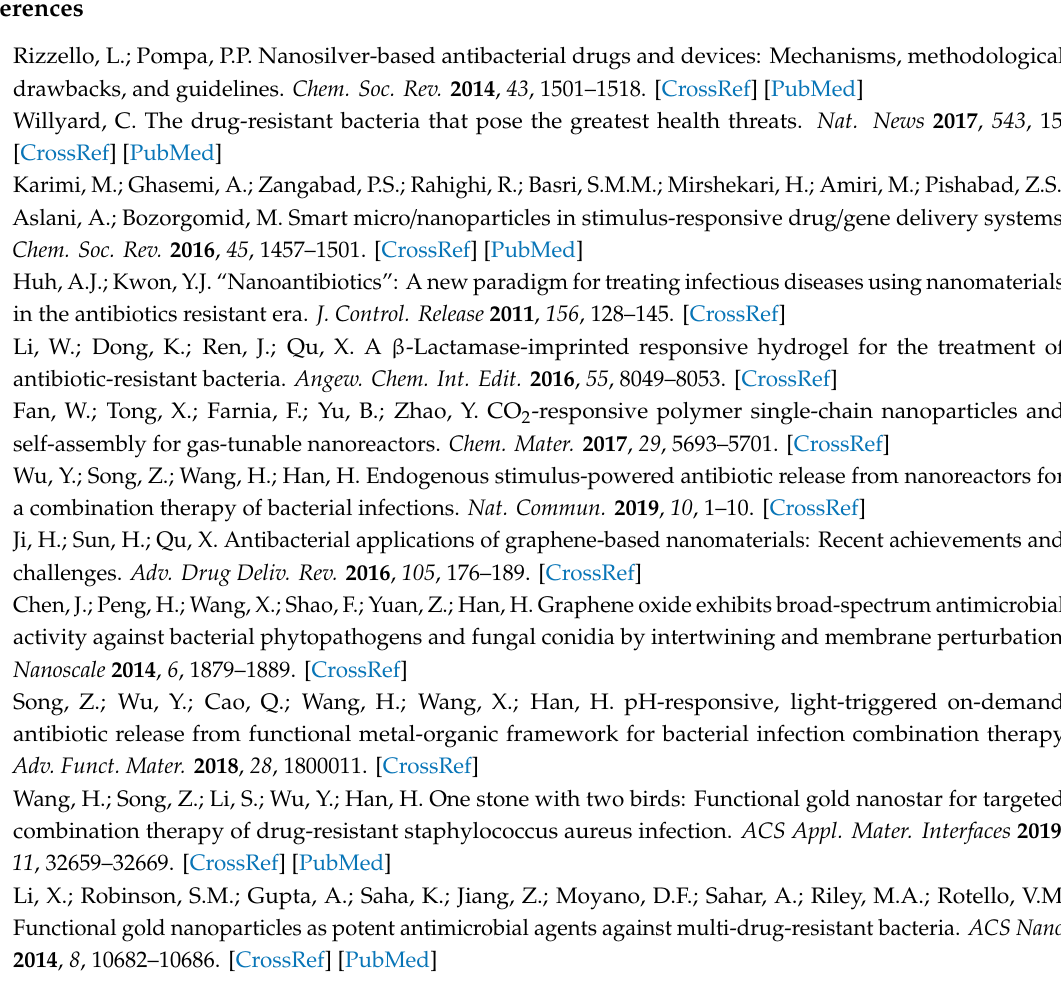
Figure S1: In vitro antibacterial activity test. Cell survival rate of Staphylococcus aureus cells treated or untreated with MnO 2